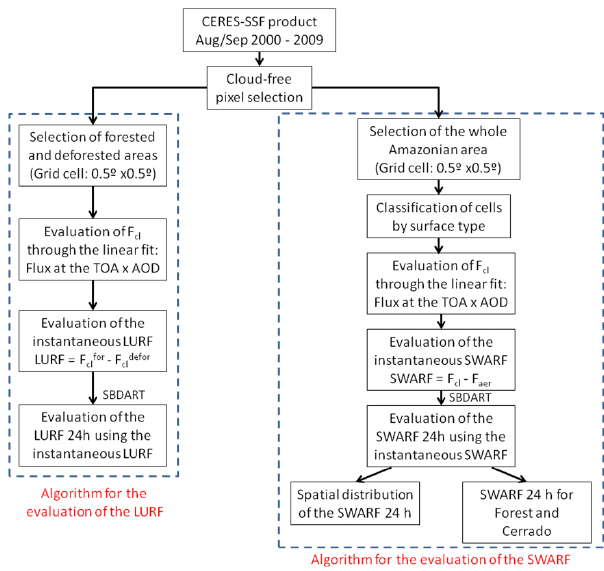
Fig. 3. Simultaneous CERES and MODIS retrievals were used for the evaluation of the mean daily shortwave aerosol radiative bud- get (SWARF) and of the mean daily surface albedo change radia- tive forcing (LURF) during the peak of the biomass burning season (August to September) from 2000 to